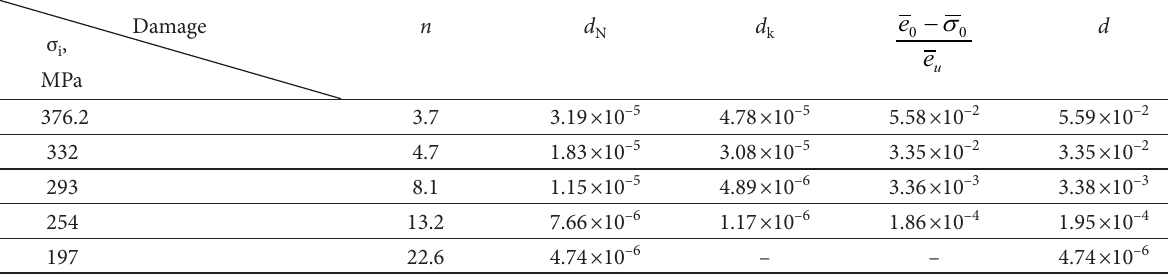
Table 7. Low cycle damage for one pulsating cycle Damage σ i